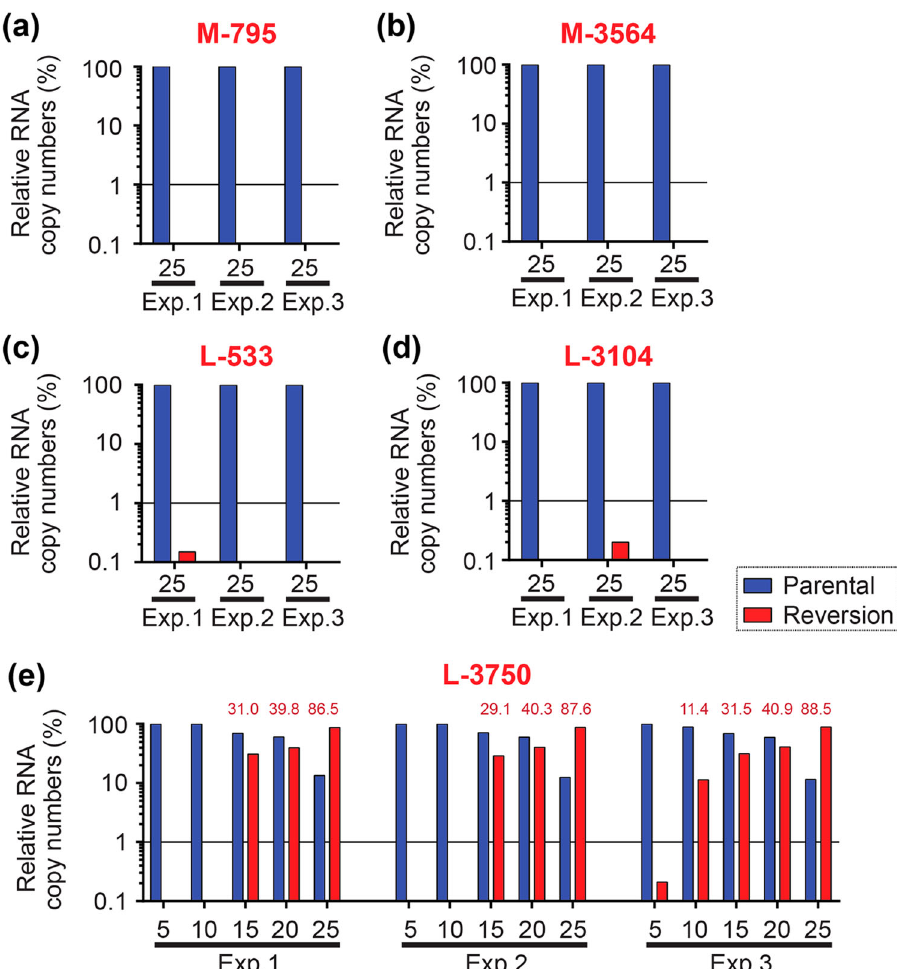
Fig. 4 Detection of reversion mutants of the MP-12 vaccine during viral passages in MRC-5 cells. The MP-12 vaccine was passaged 25 times in MRC-5 cells at MOI of 0.01 or less at 3 days post infection. Virus RNA was puri fi ed from culture supernatants and analyzed for the presence of reversion mutations using Taqman probes (shown in Supplementary Fig. 1 and Supplementary Table 2). a M-segment nt. 795: HEX-795-C and FAM-795-T, b M-segment nt. 3564: HEX-3564-G and FAM-3564-A, c L-segment nt. 533: HEX-533-C and FAM-533-T, d L-segment nt. 3104: HEX- 3104-A and FAM-3104-G, and e L-segment nt. 3750: HEX-3750-A and FAM-3750-G. Three independent studies are shown (Exp-1, 2, and 3). Relative percentages of RNA copy numbers for parental and reversion mutants are shown in blue and red bars , respectively. The bar labels in red represent the percentages of reversion